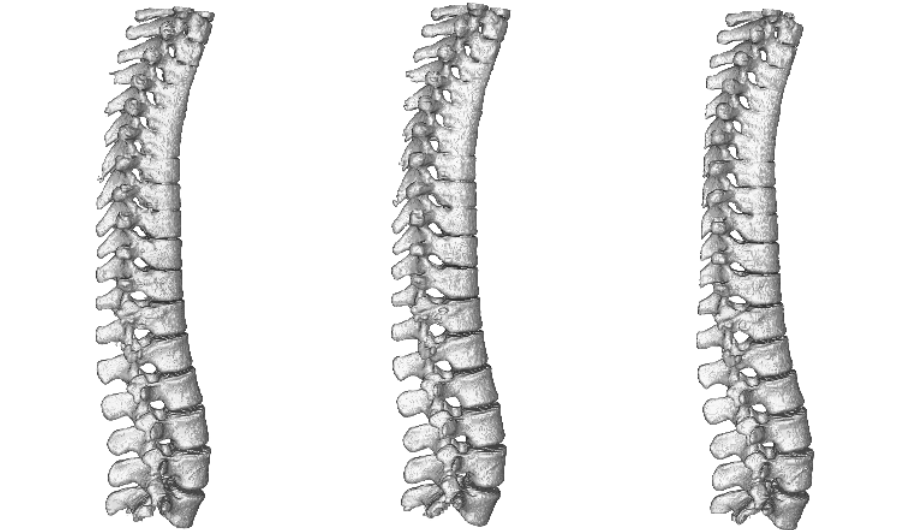
Figure 9. Visualisation of segmented spine models from the benchmark training phase. From left to right—Dense-U-Net, Residual-U-Net, U-Net. Please notice that the abnormal vertebrae adhesions exist also in original ground truth masks as can be seen in Figure 10. Table 6. Comparison of tested 3D U-Net versions on spine dataset in benchmark training phase. The training was limited by 50 epochs for each. Used metrics for evaluation are: pixel accuracy, Dice coefficient, intersection over union, average Hausdorff distance [voxel] and area under ROC curve.